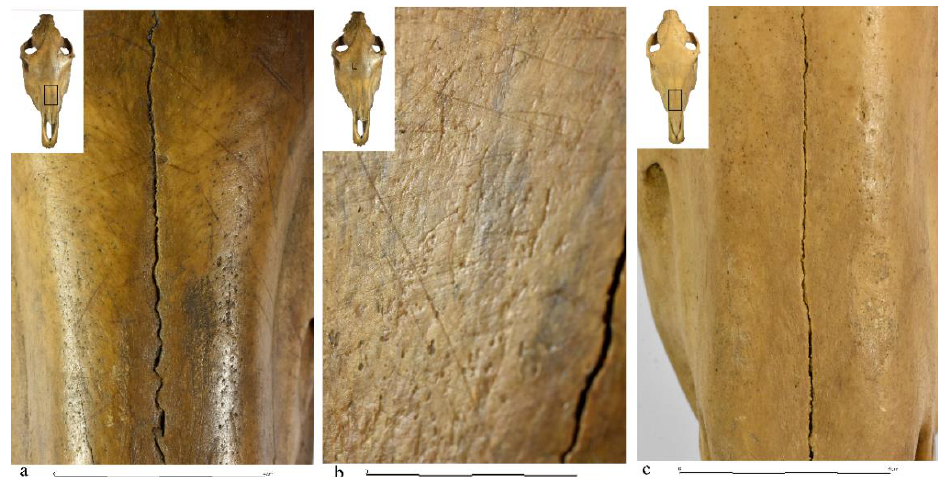
Figure 4. Two horse skulls of males from the Gda´nsk stronghold (Grodzka street, site 1). ( a , b ) scratches on the bone surface; ( c ) no scratches on the bone surface (photo by M. Gembicki).